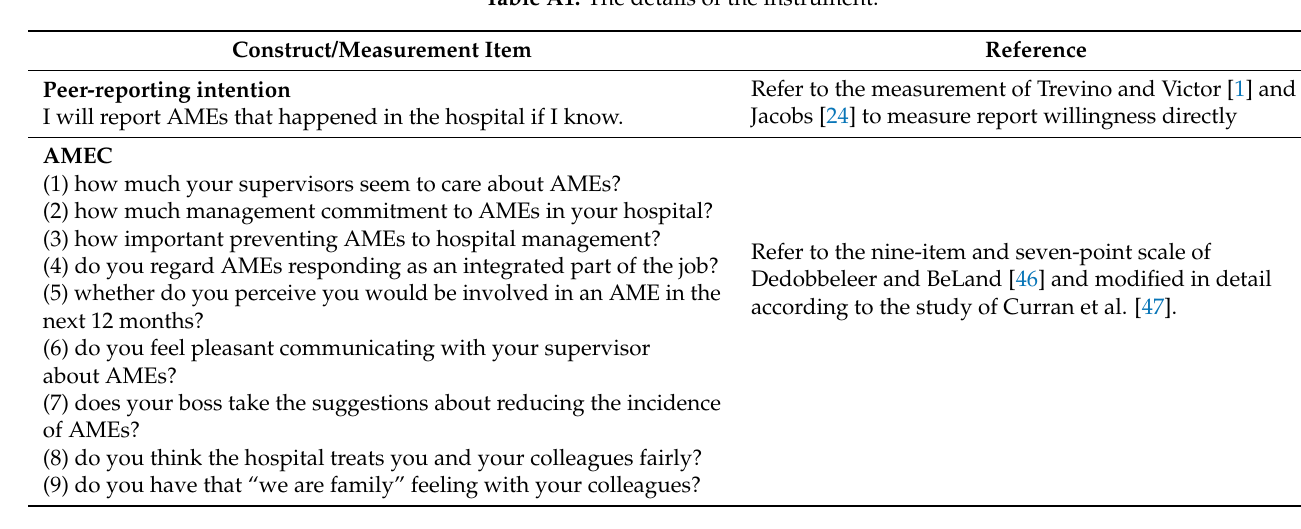
Table A1. The details of the